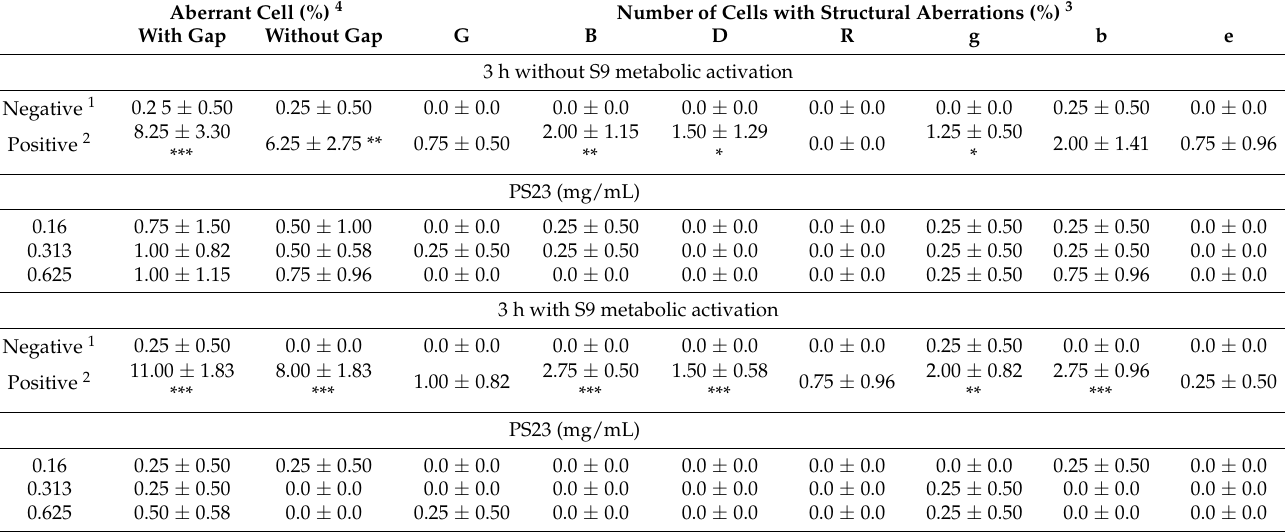
Table 3. Chromosome aberration assay of PS23 in Chinese hamster ovary